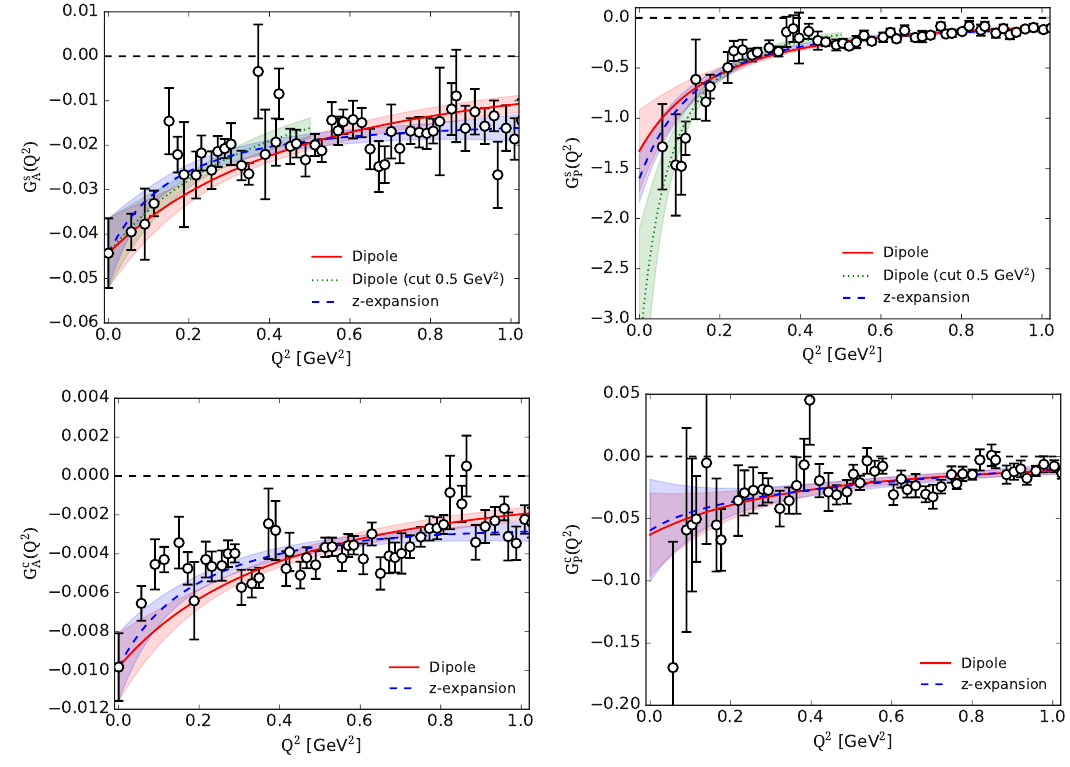
Figure 8: Left: Results for the strange G s and right: result for the strange G s function of Q 2 . We show the fits using the dipole from and z-expansion as well as the dipole form fit taking the upper fit range up to (cid:39) 0.5 GeV 2 (green dotted line and band). Figure taken from Ref. [ 26 ]